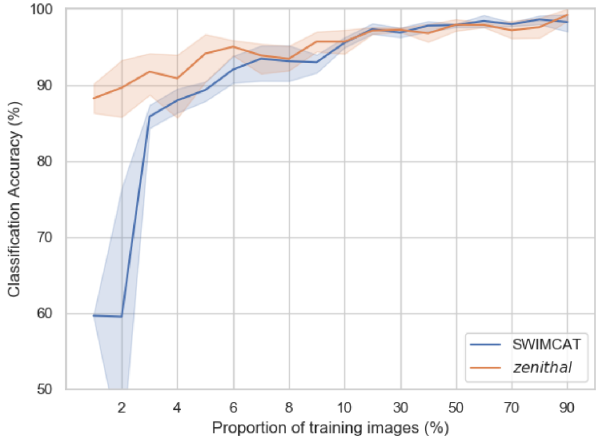
Figure 7. The confusion matrix of the SWIMCAT dataset classifi- cation results using our proposed method. Nine-tenths (9/10) of the dataset is used for training and the rest is used for testing; the overall classification accuracy is